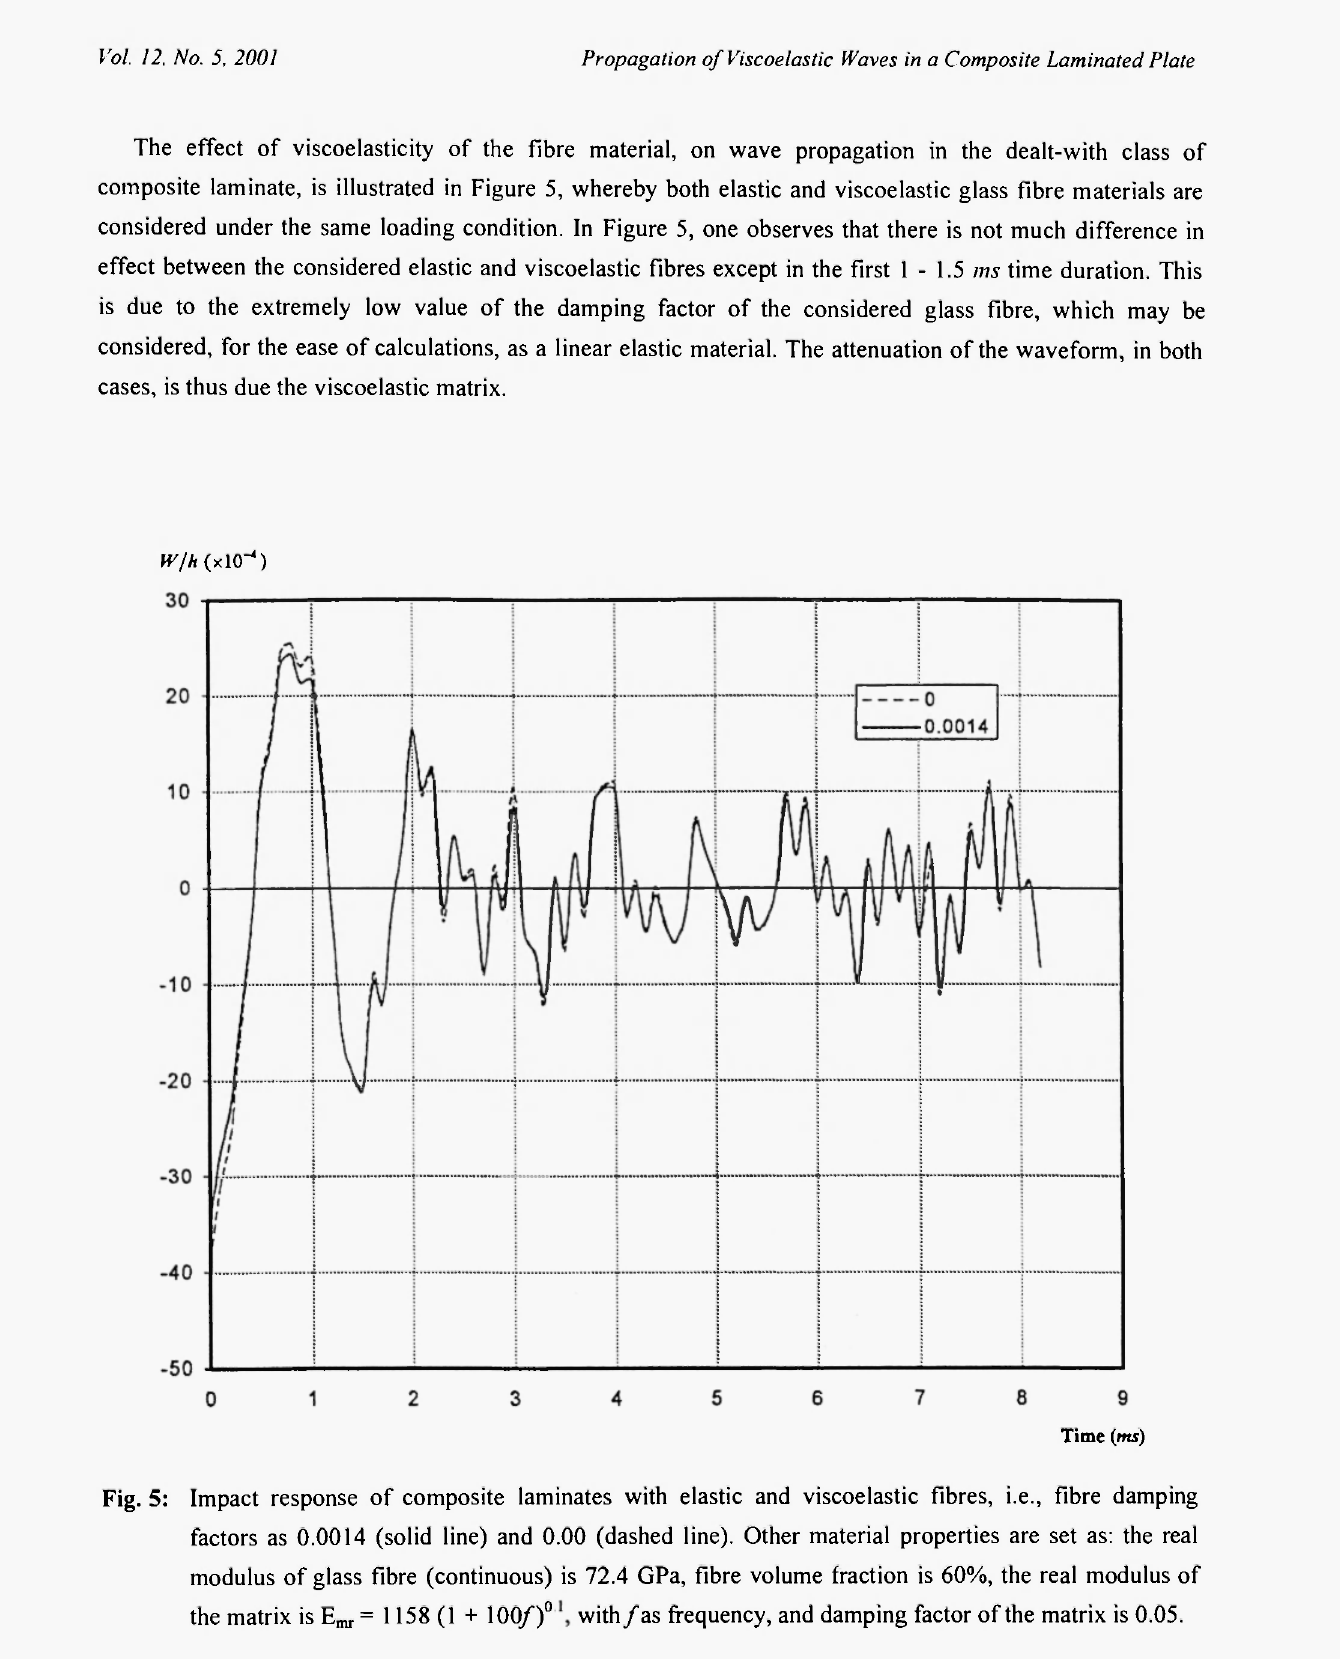
Fig. 5: Impact response of composite laminates with elastic and viscoelastic fibres, i.e., fibre damping factors as 0.0014 (solid line) and 0.00 (dashed line). Other material properties are set as: the real modulus of glass fibre (continuous) is 72.4 GPa, fibre volume fraction is 60%, the real modulus of the matrix is Em, = 1158 (1 + 1 0 0 / ) ° w i t h / as frequency, and damping factor of the matrix is 0.05.